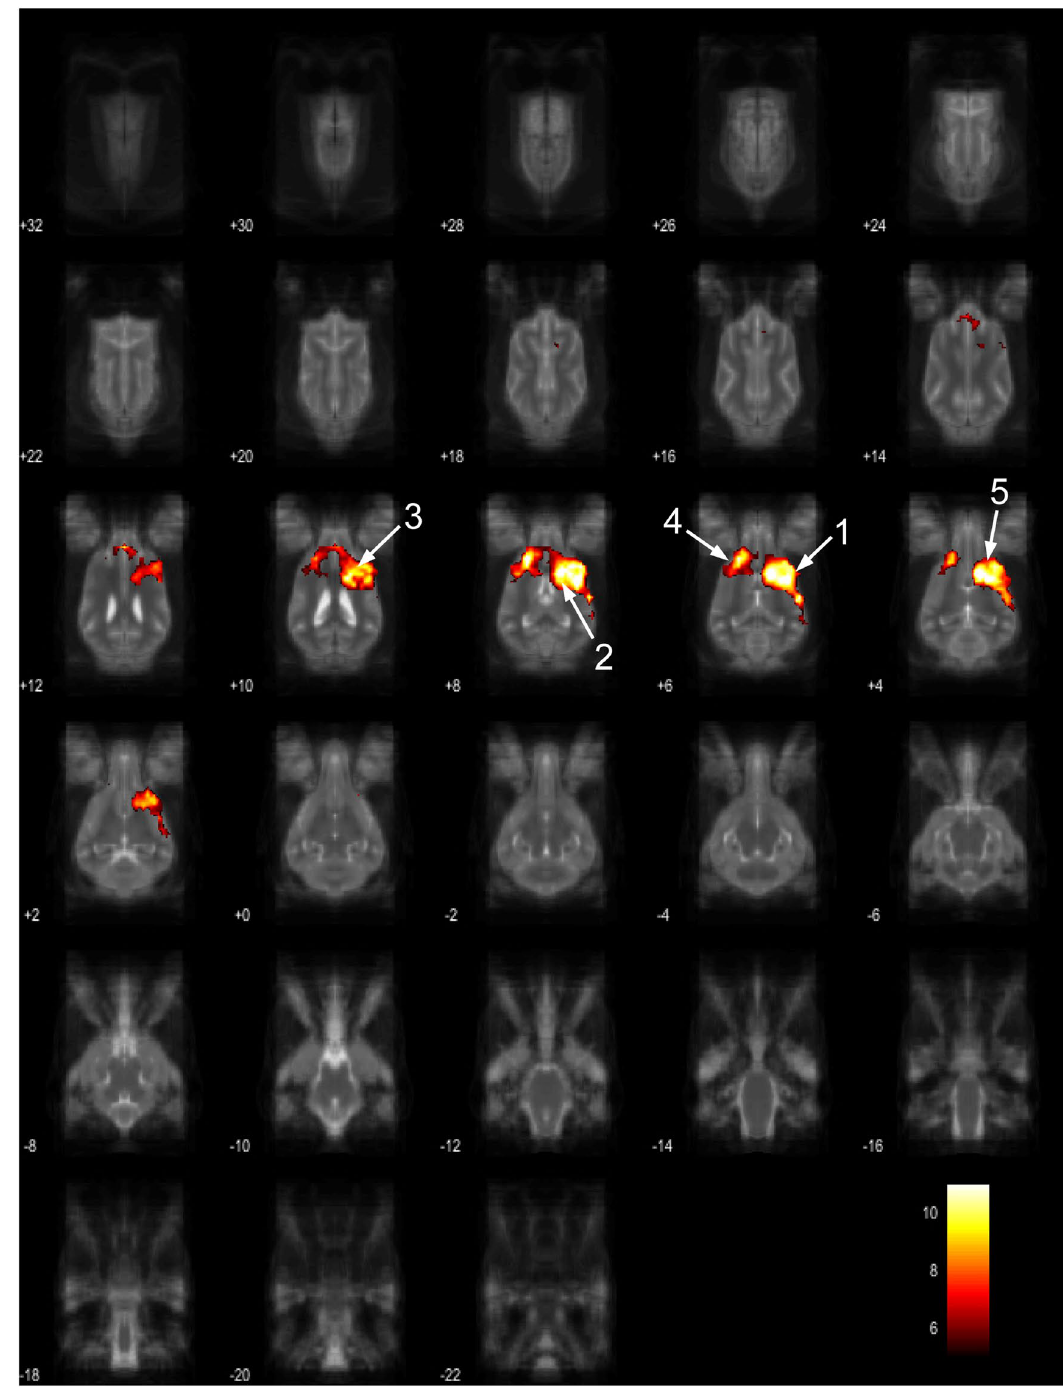
Figure 6. Resting-state network component C from the 15 component gICA. We report the results with a voxel-wise FDR corrected p < 0.001 and cluster treshold of FDR corrected p < 0.005. gICA components are presented as thresholded T-maps, corrected for multiple comparisons, overlaid on the Nitzsche atlas 15 . 1. right rostral composit gyrus, 2. right caudate nucleus, 3. right rostral suprasylvian gyrus, 4. left rostral composit gyrus, 5. prorean